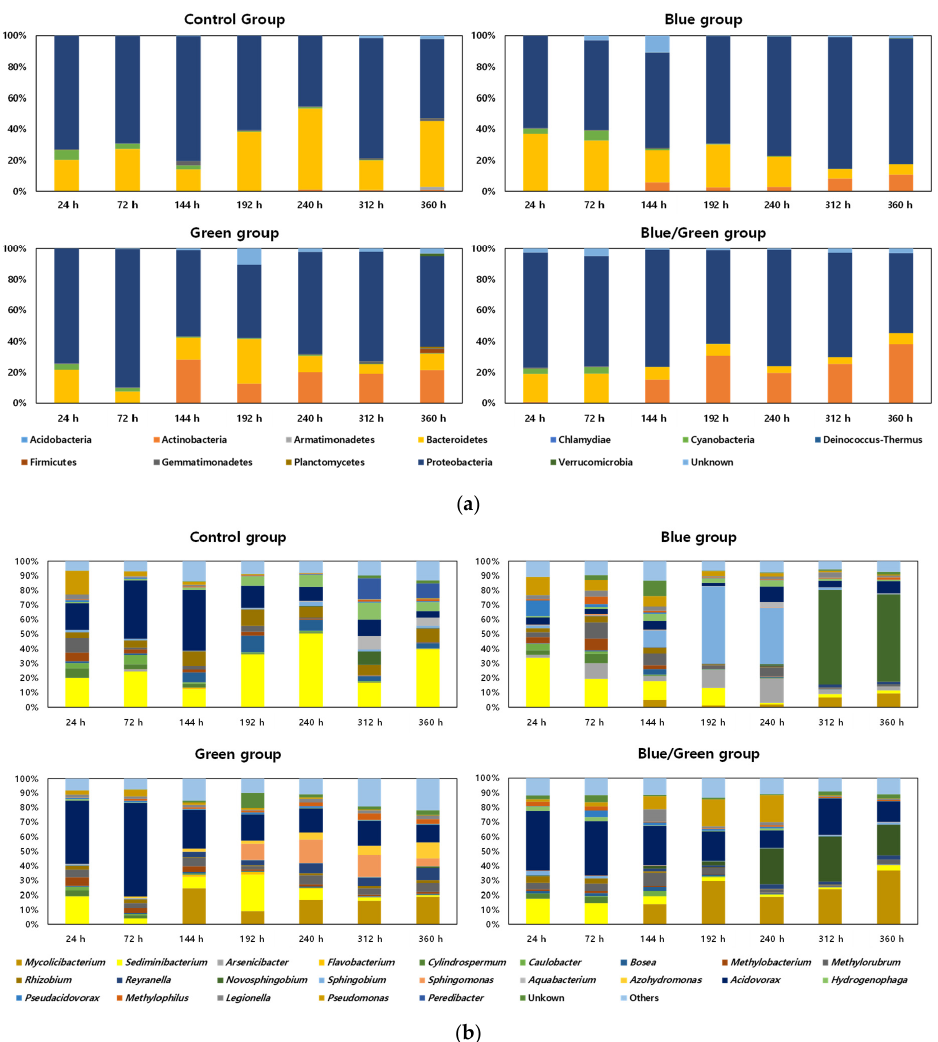
Figure 4. Relative abundance of the bacterial community (x-axis: Cultivation period, y-axis: Relative abundance of bacterial taxa). ( a ) Phylum level; ( b ) Genus level (genera with >5% abundance is listed while the rest are categorized under ‘others’).